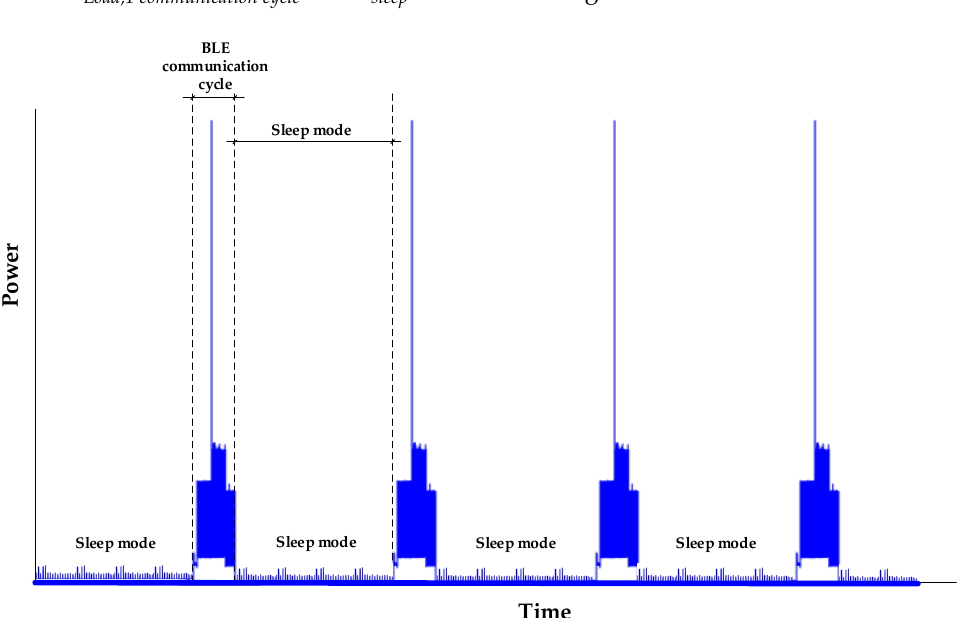
Figure 2. Power consumed by the IoT device ( SmartConnector ) during multiple BLE communication cycles separated by sleep mode periods.